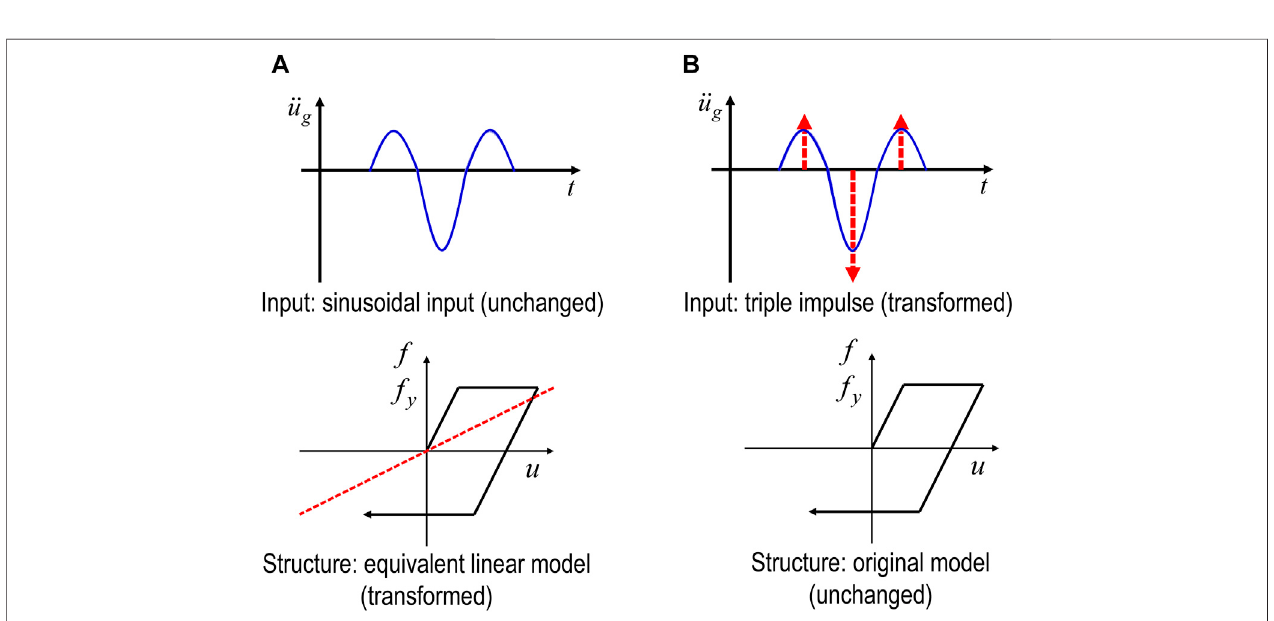
Figure 3 (input of − € u g ( t ) does not change its essence). Slipping of